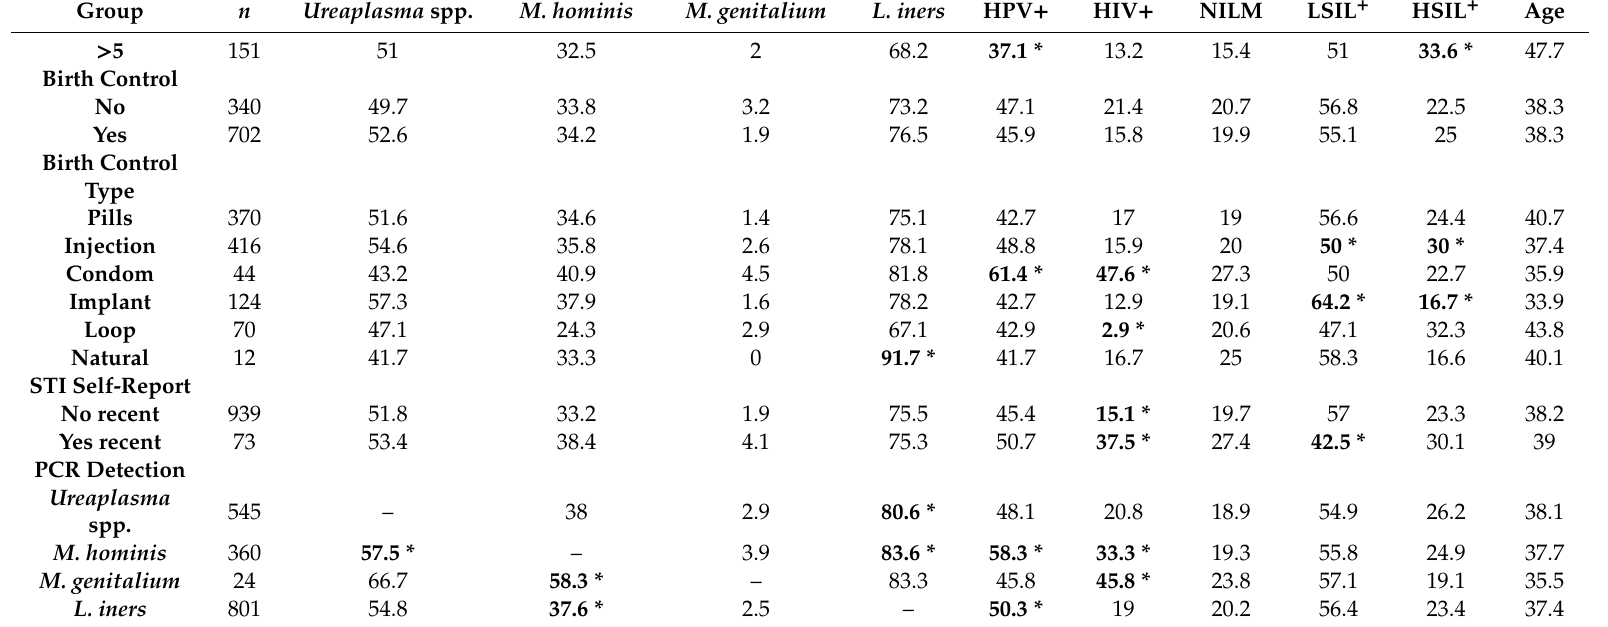
Values are listed as percentage of women positive for the condition labeled in each column. The cohort is broken down into sub-groups in each row, depending on results from testing or survey. A one-proportion Z -test was used to identify prevalence in subgroups that di ff er significantly from the cohort average. Values were considered significant when p < 0.05 and are bolded and labeled with a ‘ * ’. The column ‘LSIL + ’ includes LSIL and ASCUS pap smear results for ease of interpretation. Similarly, the column ‘HSIL + ’ includes HSIL and ASC-H pap smear results. Abbreviations: HPV (Human Papillomavirus), HIV (Human Immunodeficiency Virus), NILM (Normal for Intraepithelial Lesion or Malignancy), LSIL (Low-Grade Squamous Intraepithelial Lesion), ASCUS (Atypical Squamous Cells of Unknown Significance), ASC-H (Atypical Squamous Cells-Cannot Rule Out High Grade), HSIL (High-Grade Squamous Intraepithelial